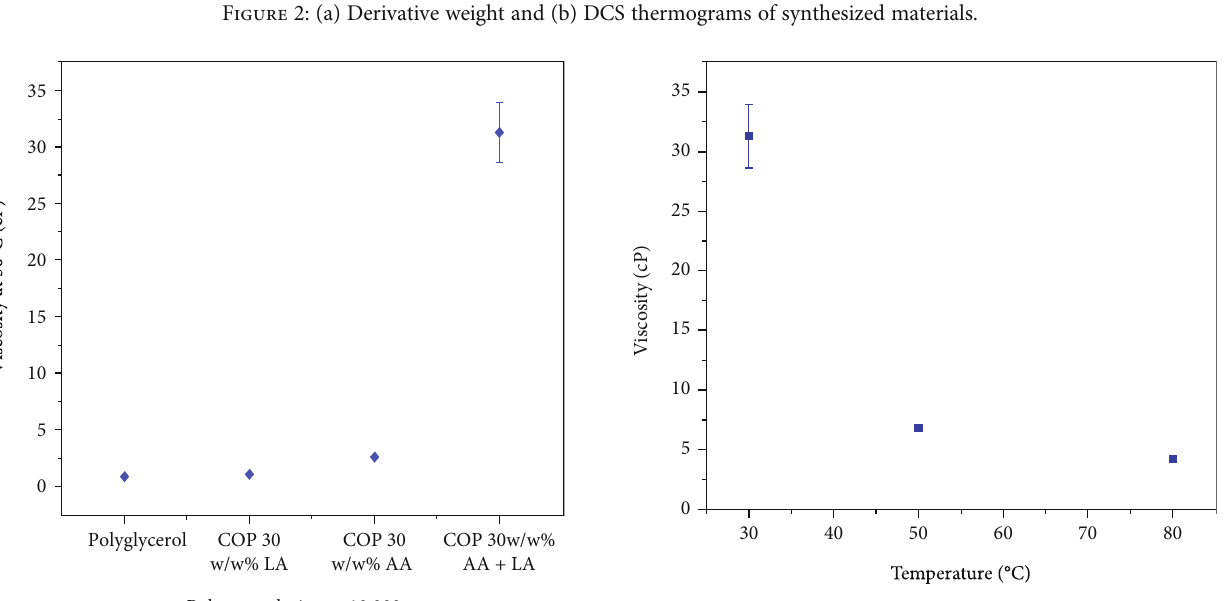
Figure 4: The viscosity of COP 30 w/w% AA+LA solution of 10.000 ppm in distilled water at di ff erent